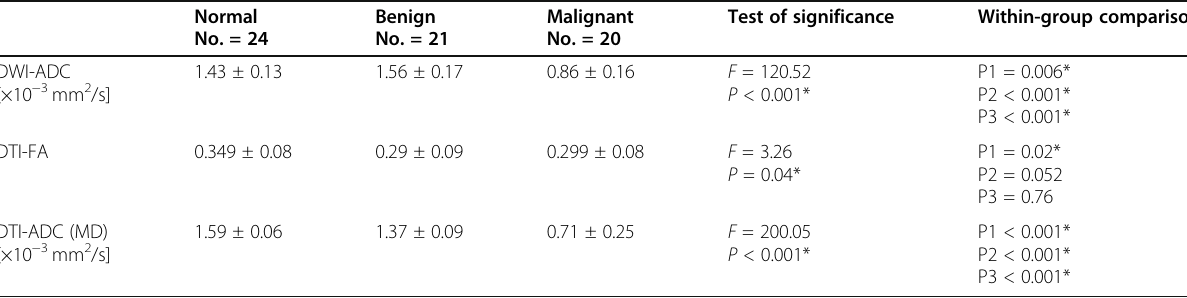
P1 = 0.006* P2 < 0.001* P3 < 0.001* P1 = 0.02* P2 = 0.052 P3 = 0.76 P1 < 0.001* P2 < 0.001* P3 <